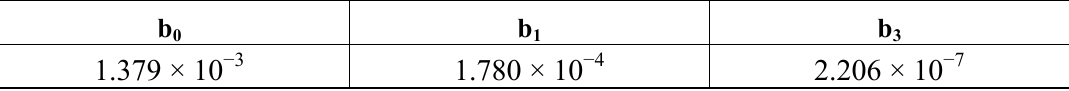
Table 3. Steinhart coefficients for the NTC.